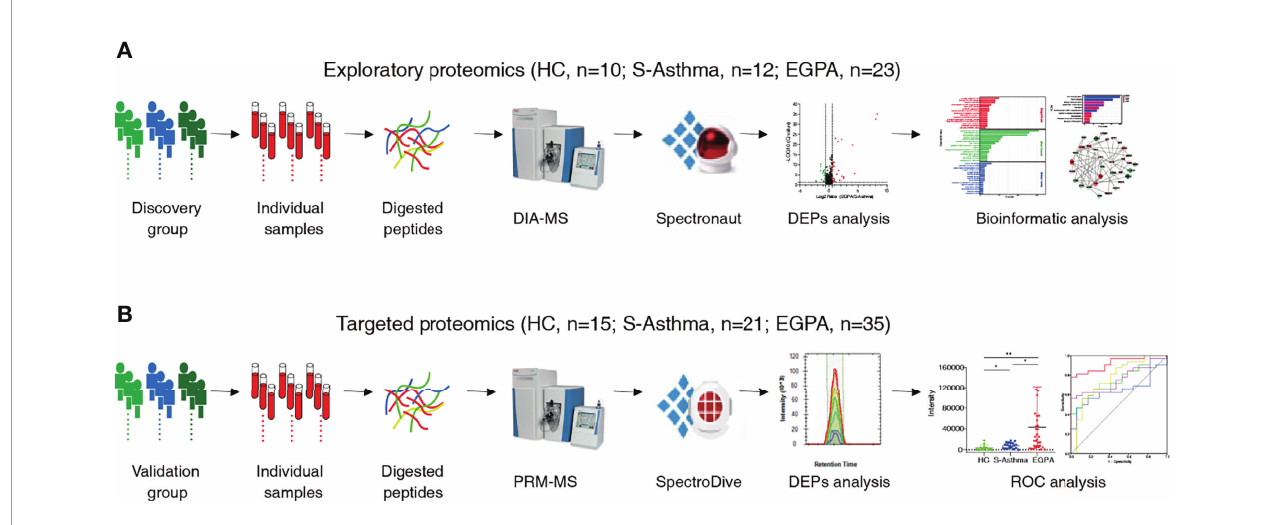
FIGURE 1 | Schematic work fl ow of the study. Work fl ow for the (A) exploratory proteomics and (B) targeted